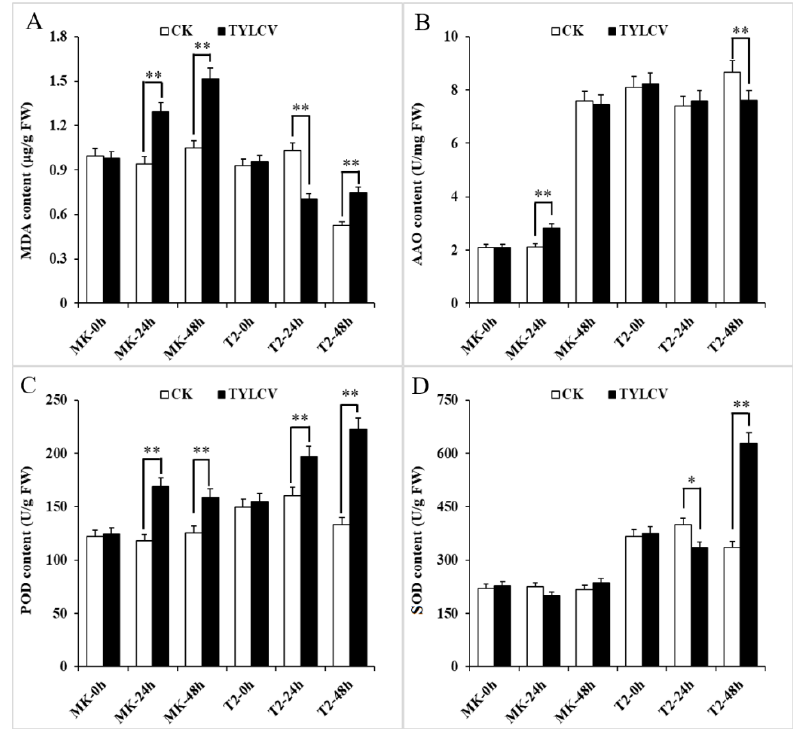
Figure 2. The MDA content and activity of reactive oxygen species (ROS)-scavenging enzymes in TYLCV-infected plant leaves. ( A ) The MDA content in treated plants. ( B, C, D ) The activities of ascorbate oxidase (AAO), peroxidase (POD), and superoxide dismutase (SOD) in treated plants, respectively. The data represent the mean ± SD ( n = 3). Data were analyzed by an ANOVA in the SPSS software. * ( p < 0.05) and ** ( p < 0.01) indicate statistically significant differences.